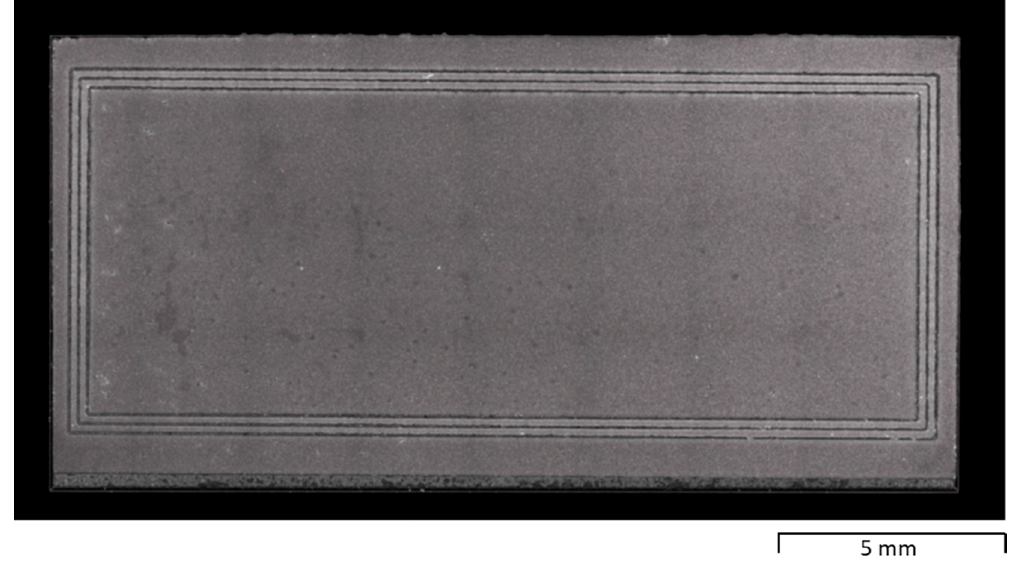
Figure 9. Micro-textured AISI316 micro-punch array with three continuous closed loop heads on the surface.